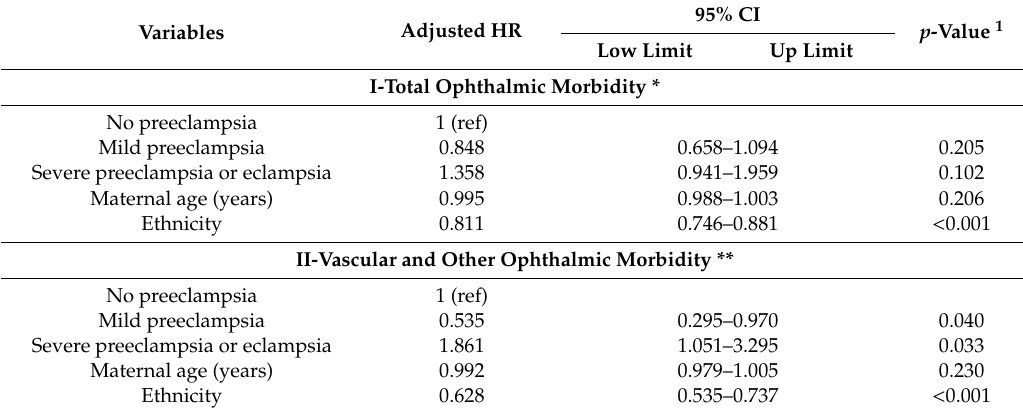
Table 3. Multivariable analyses of long-term total ophthalmic morbidity and vascular and other morbidity in offspring prenatally exposed to preeclampsia.